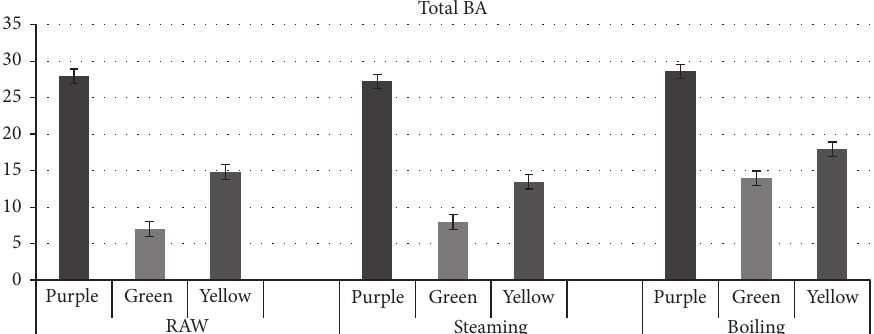
Figure 2: Effect on the total level of biogenic amines (mg/100g FW) of steaming and boiling treatment of three varieties of green